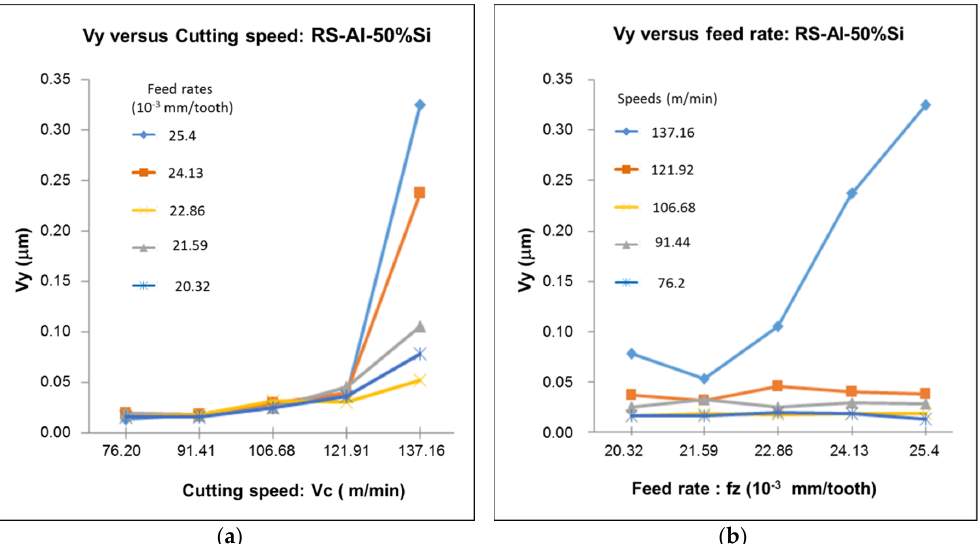
Figure 14. Evolution of the vibration as a function of the variation of ( a ) cutting speed and ( b ) feed rate for the RS Al–50%Si alloy. Materials 2020 , 13 , x FOR PEER REVIEW